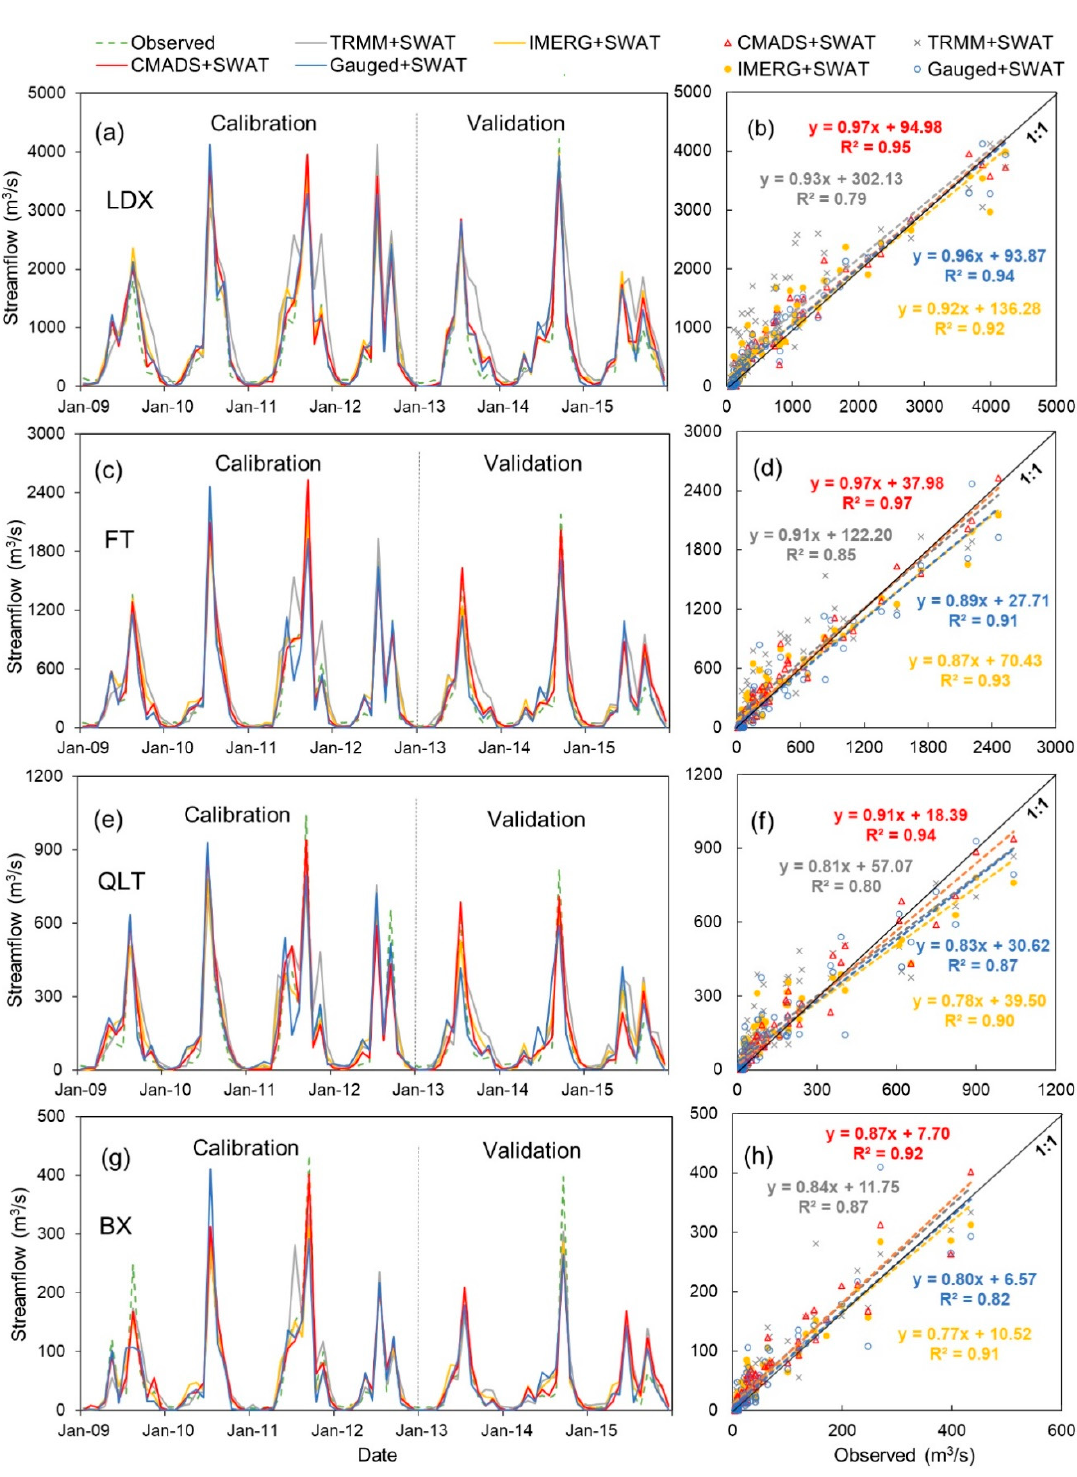
Figure 7. The hydrograph and scatterplot (dashed line represents linear fit) of the monthly streamflow in the calibration and validation period. ( a , b ) LDX; ( c , d ) FT; ( e , f ) QLT; ( g , h ) BX.